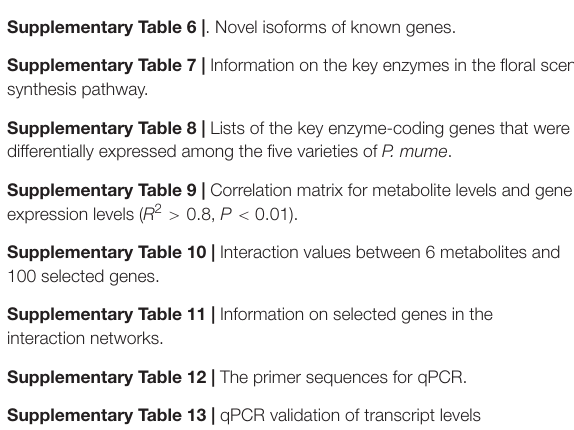
Supplementary Table 2 | Analysis of intracellular pools of floral scent metabolites in five varieties of P. mume by GC-MS. Supplementary Table 3 | Quality analysis of all reads from fifteen samples.